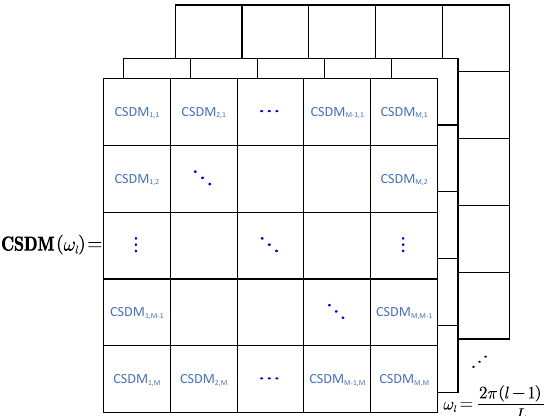
Figure 2. The cross-spectral density matrix schematic